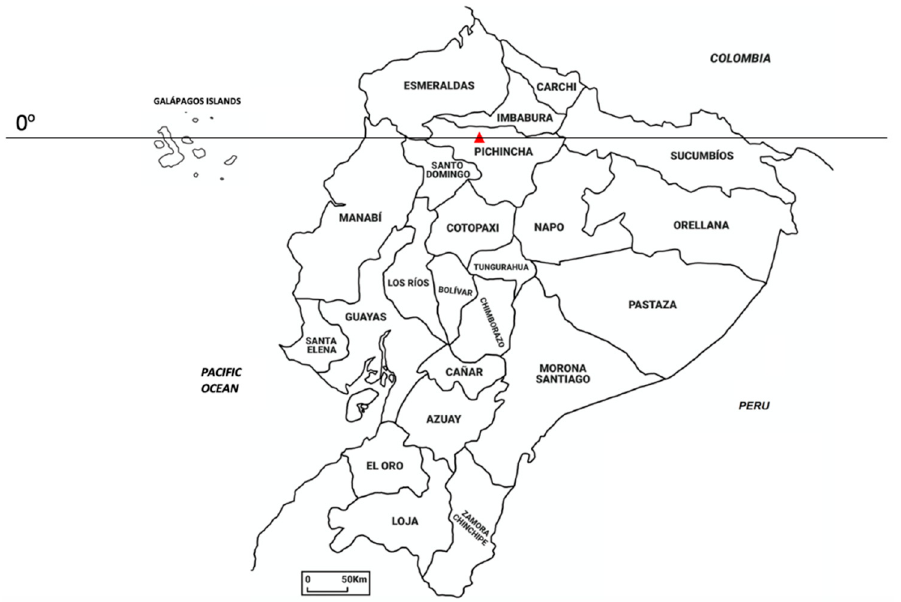
Figure 1. Provinces of Ecuador.